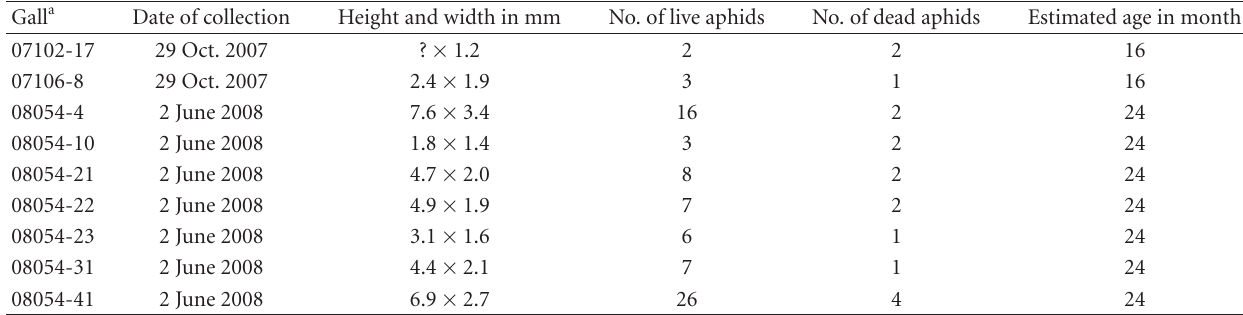
Table 1: Some galls of Nipponaphis monzeni whose growth seems to have been delayed. Gall a